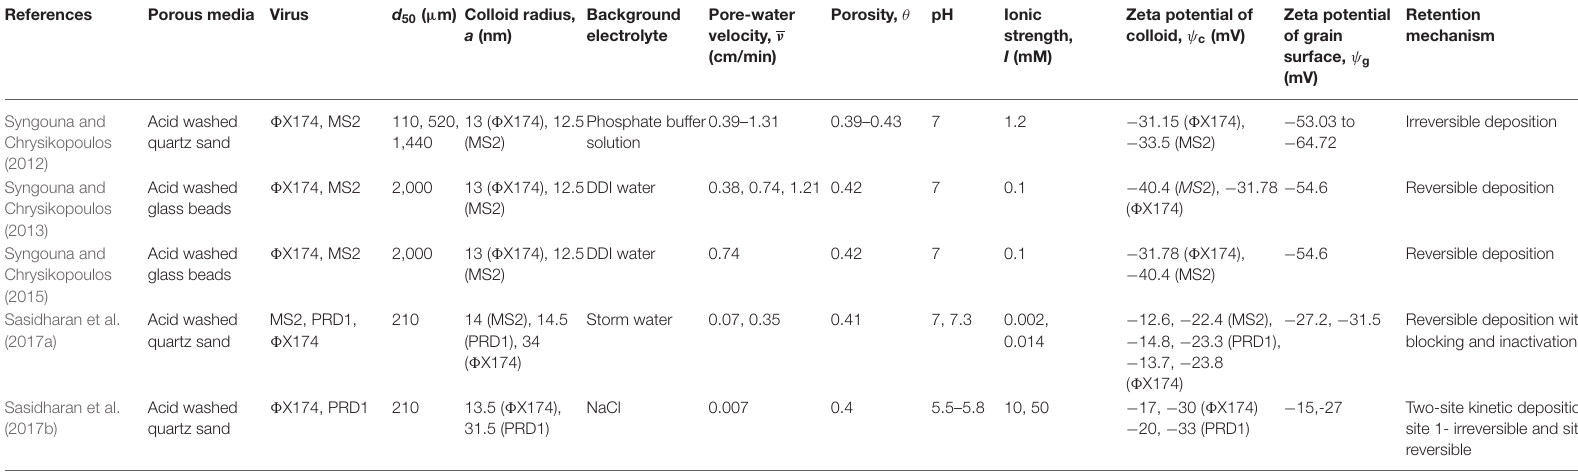
TABLE 1 | Experimental conditions in papers selected to analyse deposition of viruses.